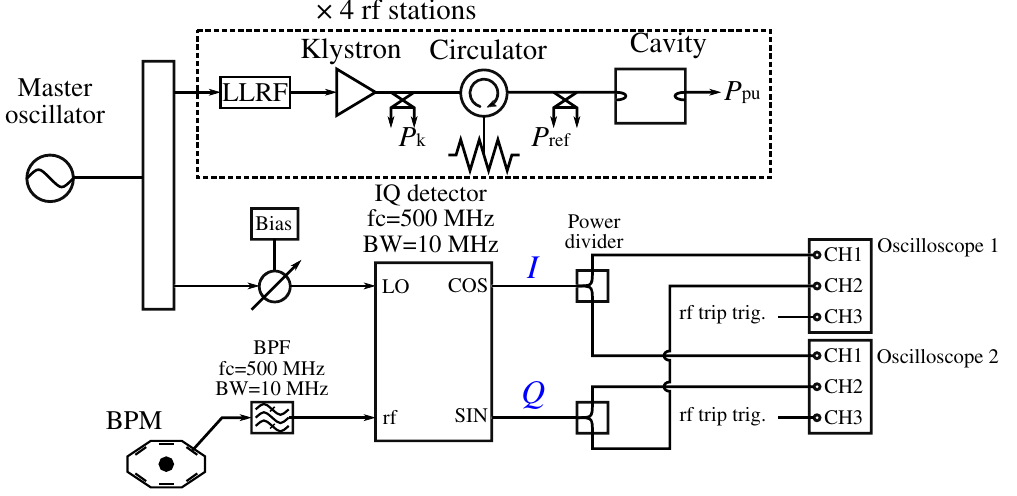
FIG. 3. The experimental setup used to observe the static Robinson instability.